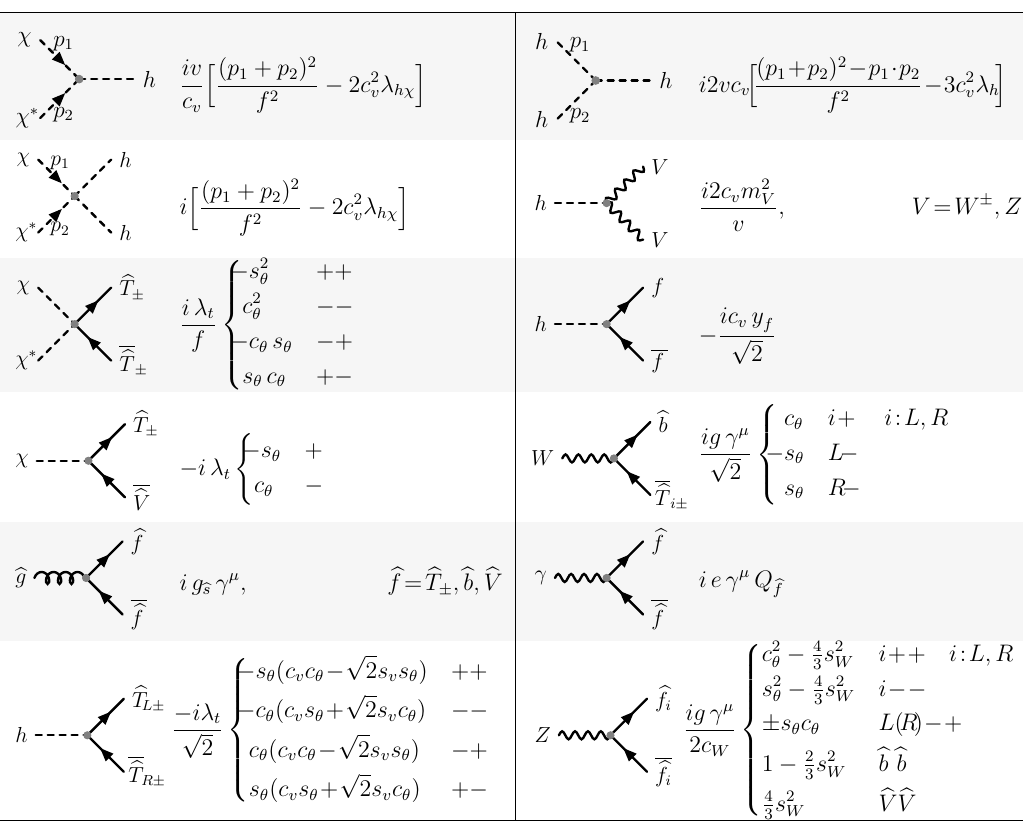
Table 1 . Some of the most relevant Feynman rules of our model are listed in this table, see the text for the corresponding